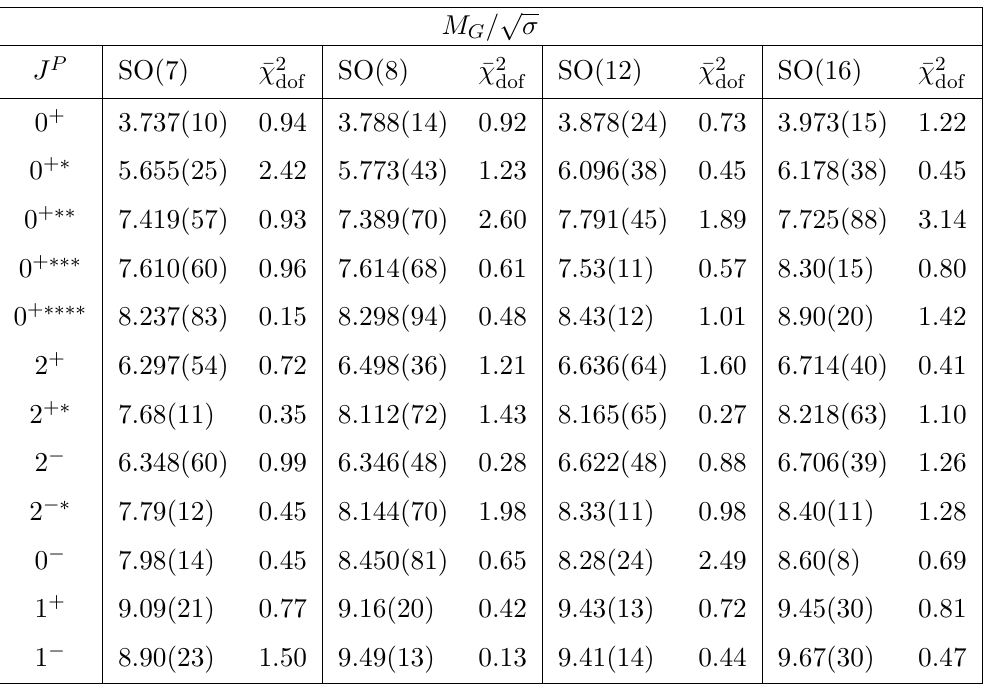
p (cid:27) , for SO(7), SO(8), SO(12),